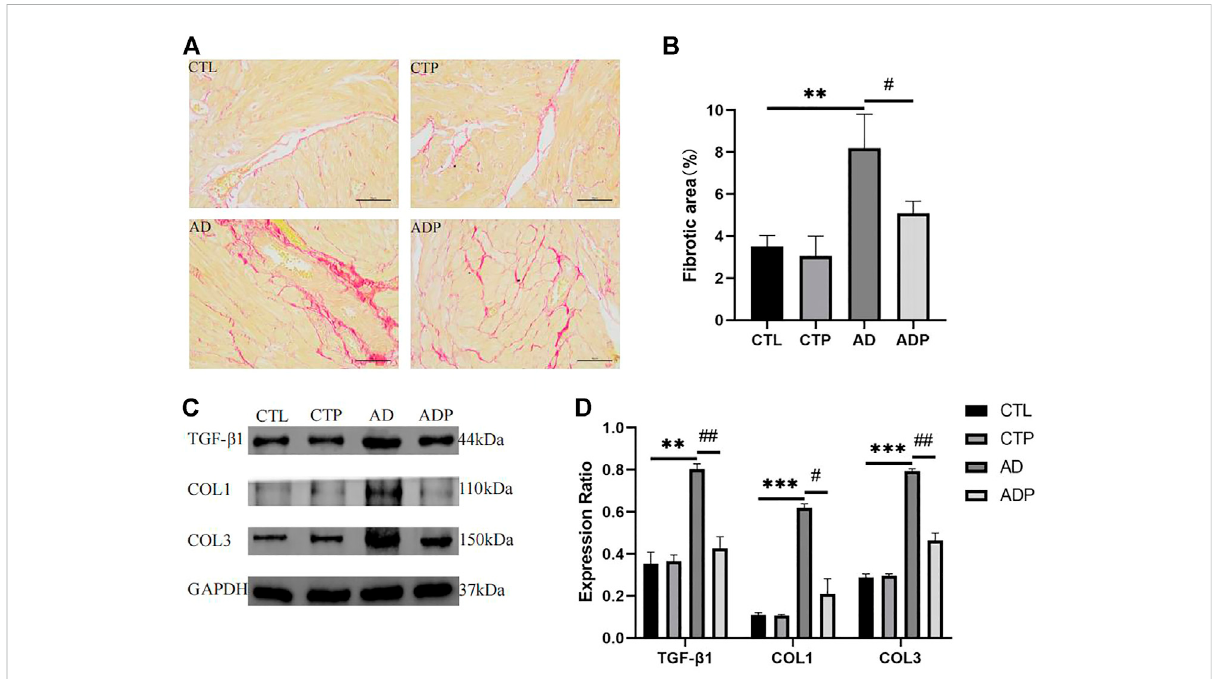
FIGURE 7 Atrial fi brosis. (A,B) Typical images of Sirius red staining and percentage of the fi brosis area, n = 5 per group. (C,D) Immunoblotting and quantitativeanalysisofTGF- β 1,collagenI,andcollagenIII, n =3pergroup.* p < 0.05,** p < 0.01,*** p < 0.001vs.CTL;# p < 0.05,## p < 0.01,### p < 0.001 vs.